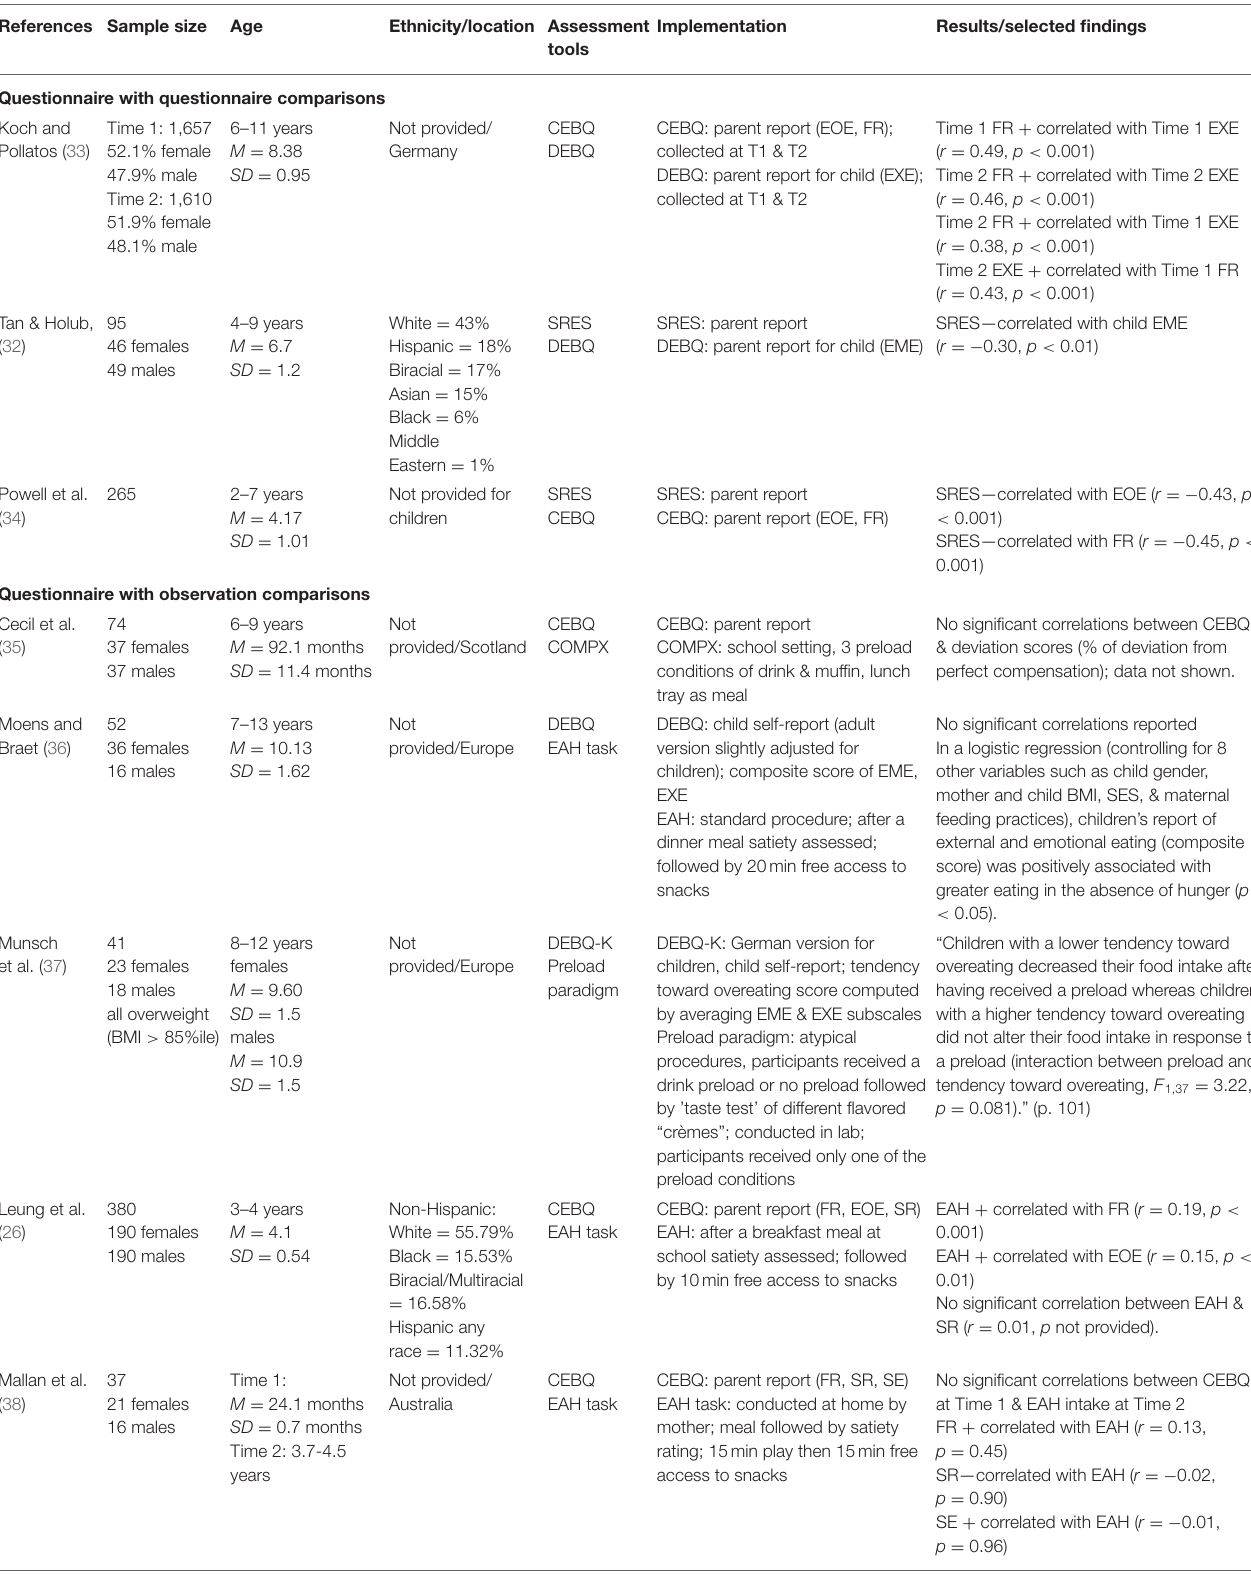
TABLE 2 | Characteristics and selected findings of included